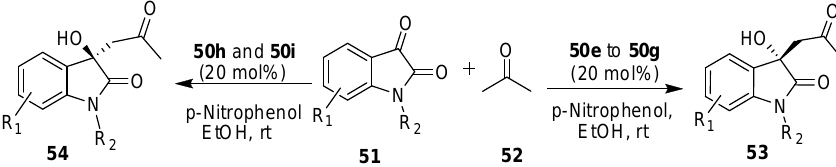
Scheme 20. Aldol reaction using β -amino amides as catalysts.